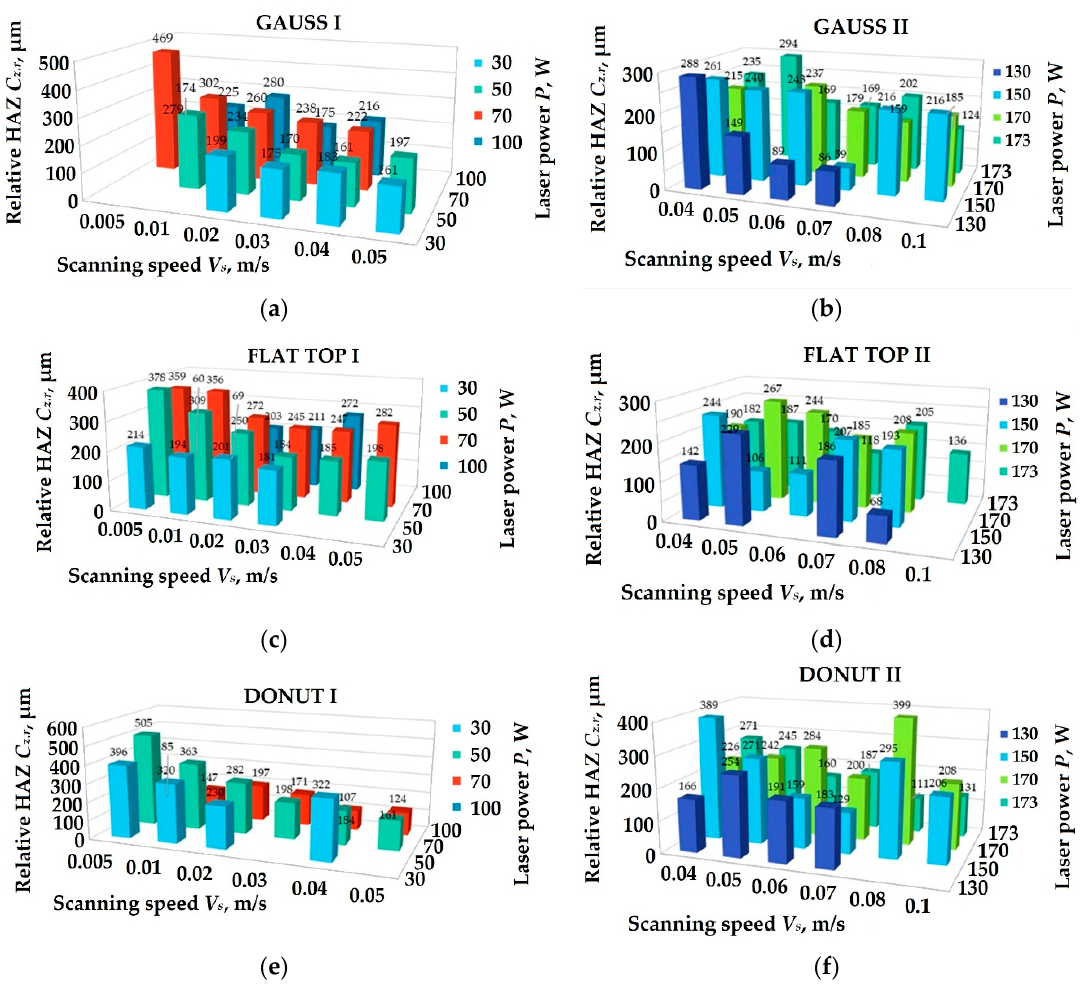
Figure 12. Dependence of relative heat-affected zone width of single tracks on process parameters for CoCrMo powder: ( a ) technological gap I of Gauss; ( b ) technological gap II of Gauss; ( c ) technological gap I of flat top; ( d ) technological gap II of flat top; ( e ) for technological gap I of donut; ( f ) technological gap II of donut.